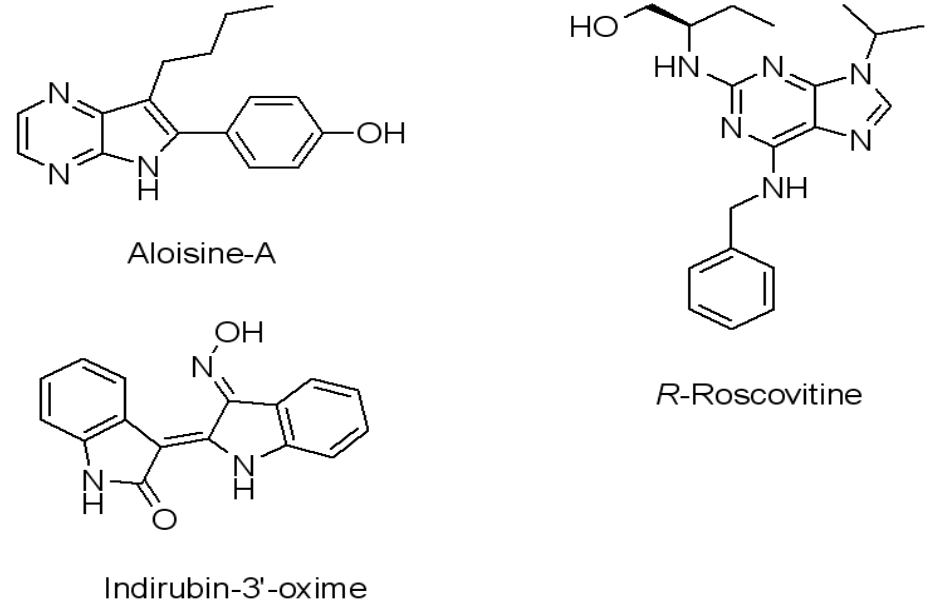
Figure 3. Structures of aloisine-A, indirubin-3'-oxime, R -roscovitine used in the